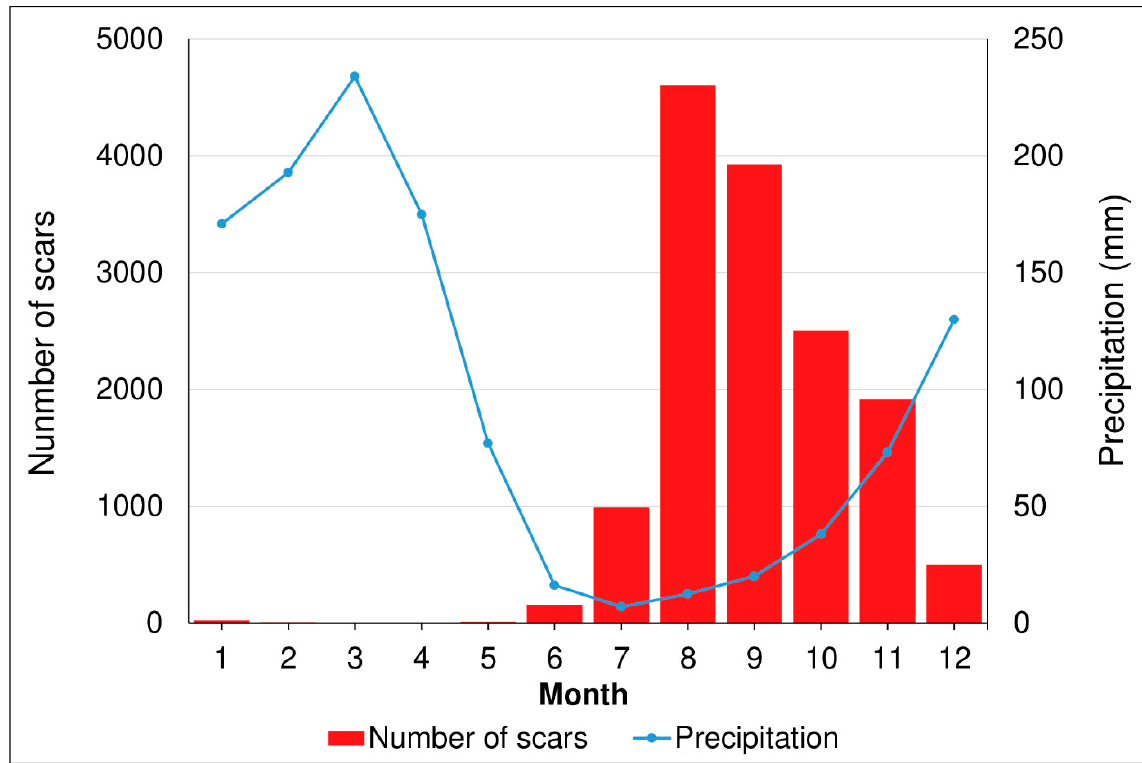
Figure 5. Burned area by month (red bars), together with mean monthly precipitation in the ILs and the surrounding areas (blue line).